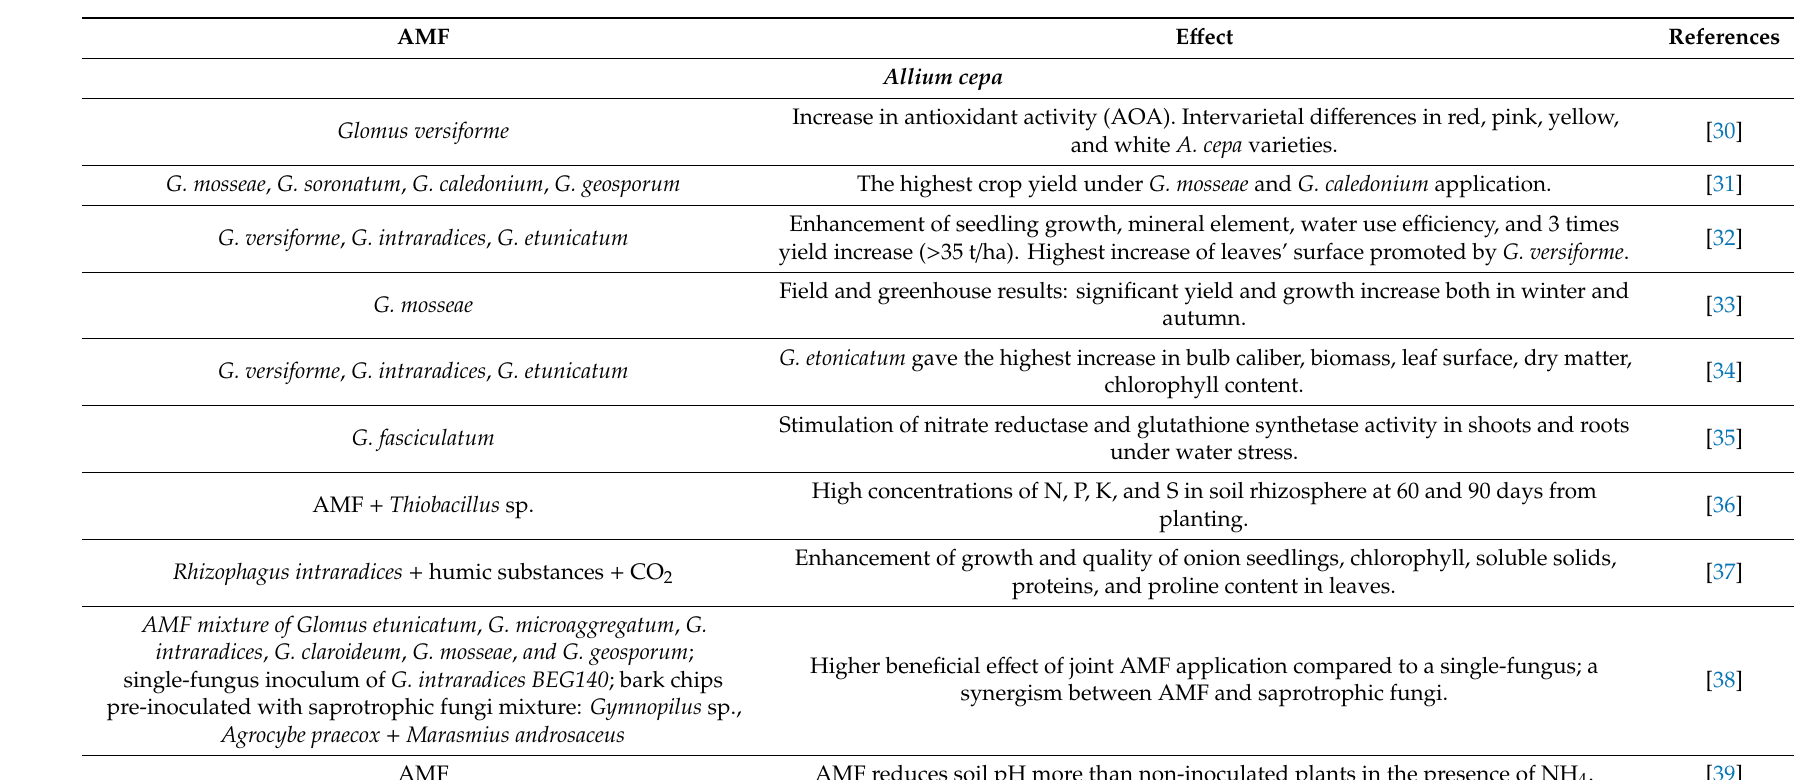
Table 1. Arbuscular mycorrhizal fungi (AMF) application on Allium